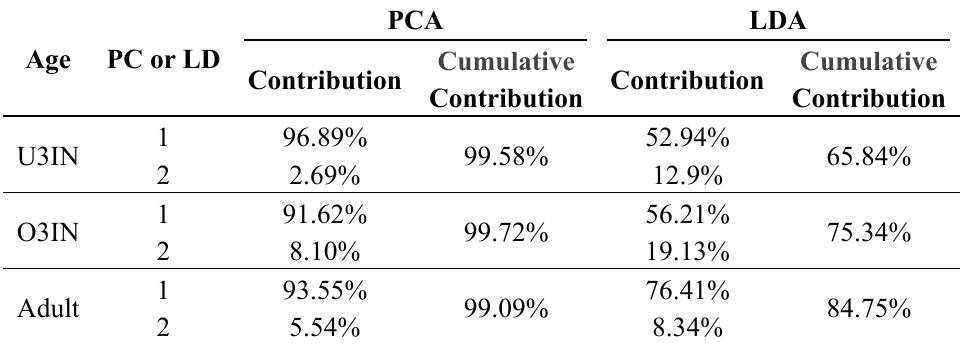
Table 3. The contribution of PCs or LDs for different amounts of BRPHs of different ages.